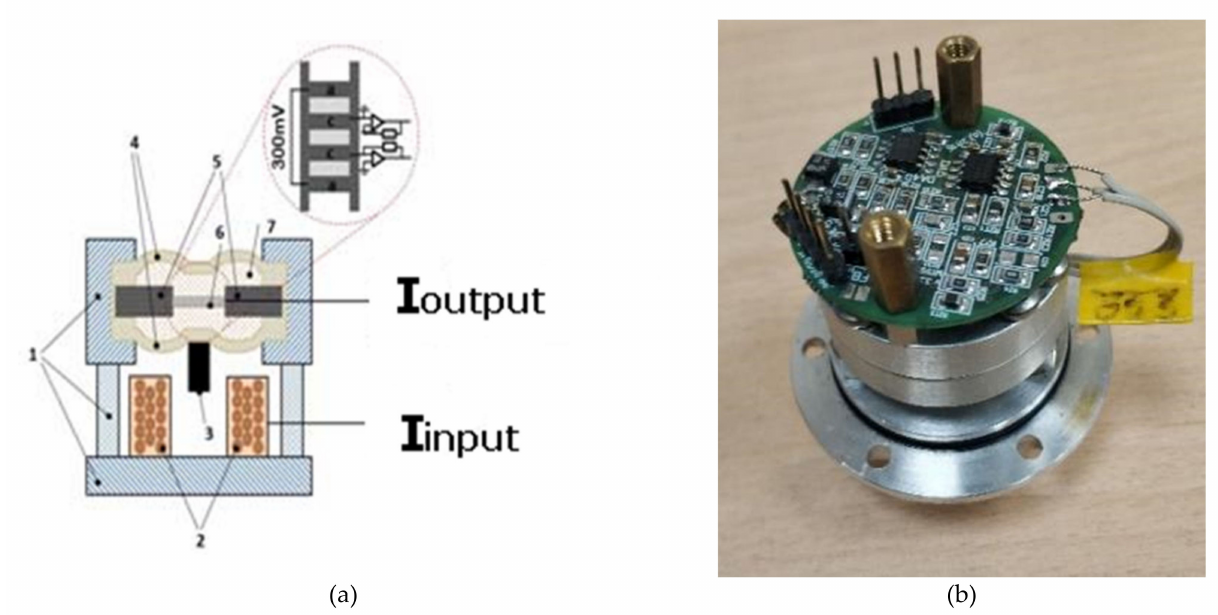
Figure 5. Sample assembled with the electrodynamic calibrator. ( a ) diagram of the device; ( b ) actual view. 1—sensor body with the coil holder; 2—coil; 3—magnet; 4—membranes; 5—holder of the conversion element; 6—conversion element; 7—electrolyte